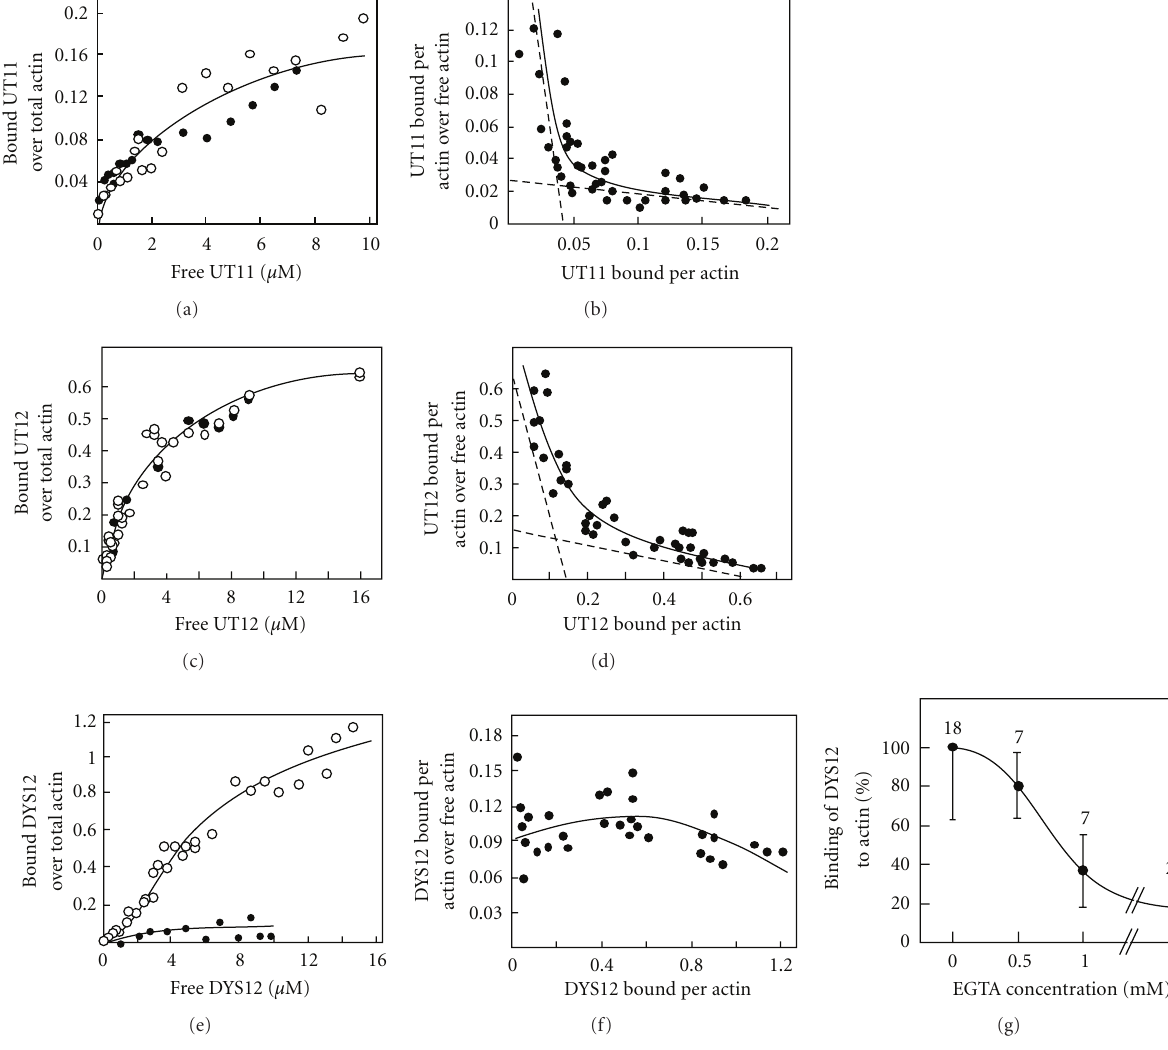
Figure 6: Binding of utrophin and dystrophin fragments to actin by cosedimentation. Assays were carried out in 2mM MgCl 2 and 0.5 mM CaCl 2 ( O ) or 6mM MgCl 2 and 5 mM EGTA ( • ). Saturation curves for binding of UT11 (a), UT12 (c), and DYS12 (e) at the left side with the corresponding Scatchard plots at the right (b, d, f). The binding curves resulted from 7 separate experiments each. All data points ( • ) are incorporated in the Scatchard plots except for DYS12 in the presence of EGTA. The concave Scatchard curves (b, d) indicate the presence of a higher and a lower a ffi nity due to either two classes of binding sites or, alternatively, negative cooperativity. The convex curve (f) suggests positive cooperativity of DYS12 binding. Binding of DYS12 to actin was also measured with increasing concentrations of EGTA (g) in the presence of 1 mM CaCl 2 in excess over the EGTA. Numbers at data points refer to the number of experiments. Error bars indicate SEM with P < 0 . 001 for 0 and 0.5 versus 1.0 and 5.0 mM EGTA. The small di ff erences between 0 versus 0.5 and 1.0 versus 5.0mM EGTA were not significant. For further explanation, see the